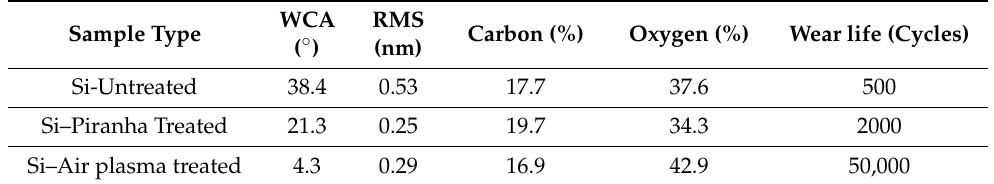
Table 5. Various measured parameters: WCA, RMS, Carbon content, Oxygen content–Measured before and after the pre-treatments; Wear life–Ball on disk wear tests conducted on UHMWPE coatings at a normal load of 1 N and a sliding speed of 0.042 m/s. Data From [58].